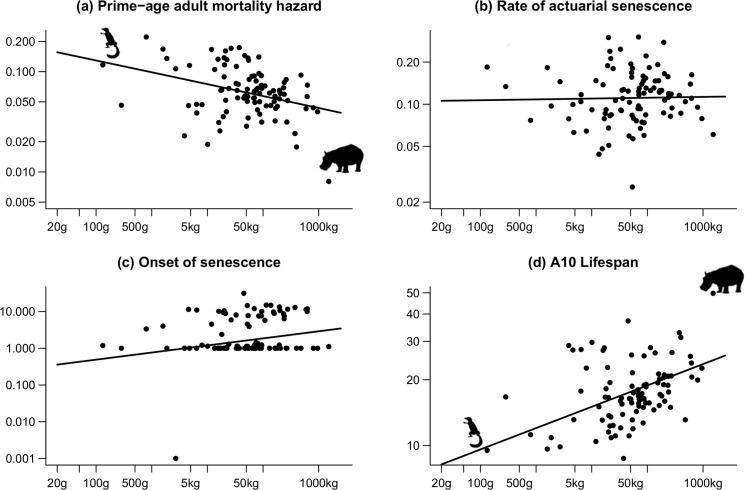
Species-specific estimates of the (a) prime-age mortality hazard, (b) the rate of actuarial senescence, (c) the onset of actuarial senescence (in years), and (d) the 10% life span (in years), plotted against the species-specific body mass. The regression lines are from phylogenetic generalized least square regressions. Note the log scale on both axes. The pictograms represent the lightest and heaviest species in the sample (tree shrew Tupaia glis and hippopotamus Hippopotamus amphibius). The data for this figure are accessible online as S2 Data.